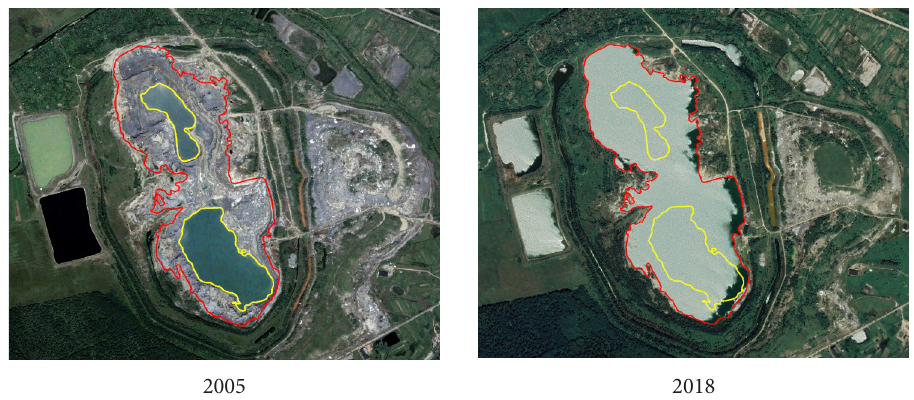
Figure 4. Brines’ waterlogging dynamic of Dombrowski quarry, look of space images.